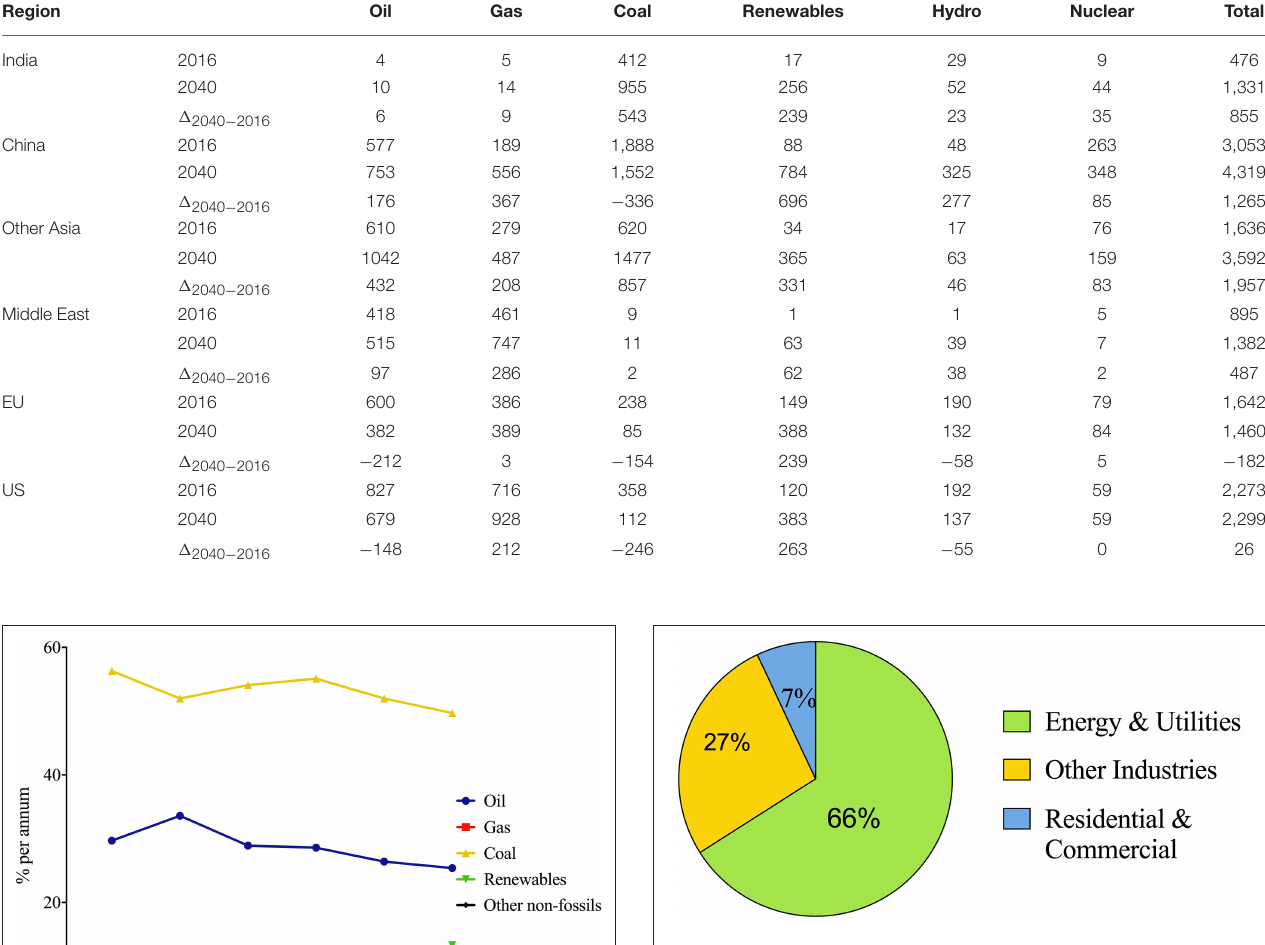
FIGURE 5 | Sectoral distribution of CO 2 emissions in India. Data Source: Department of Science and Technology, Govt. of India ( Department of and Science Technology,